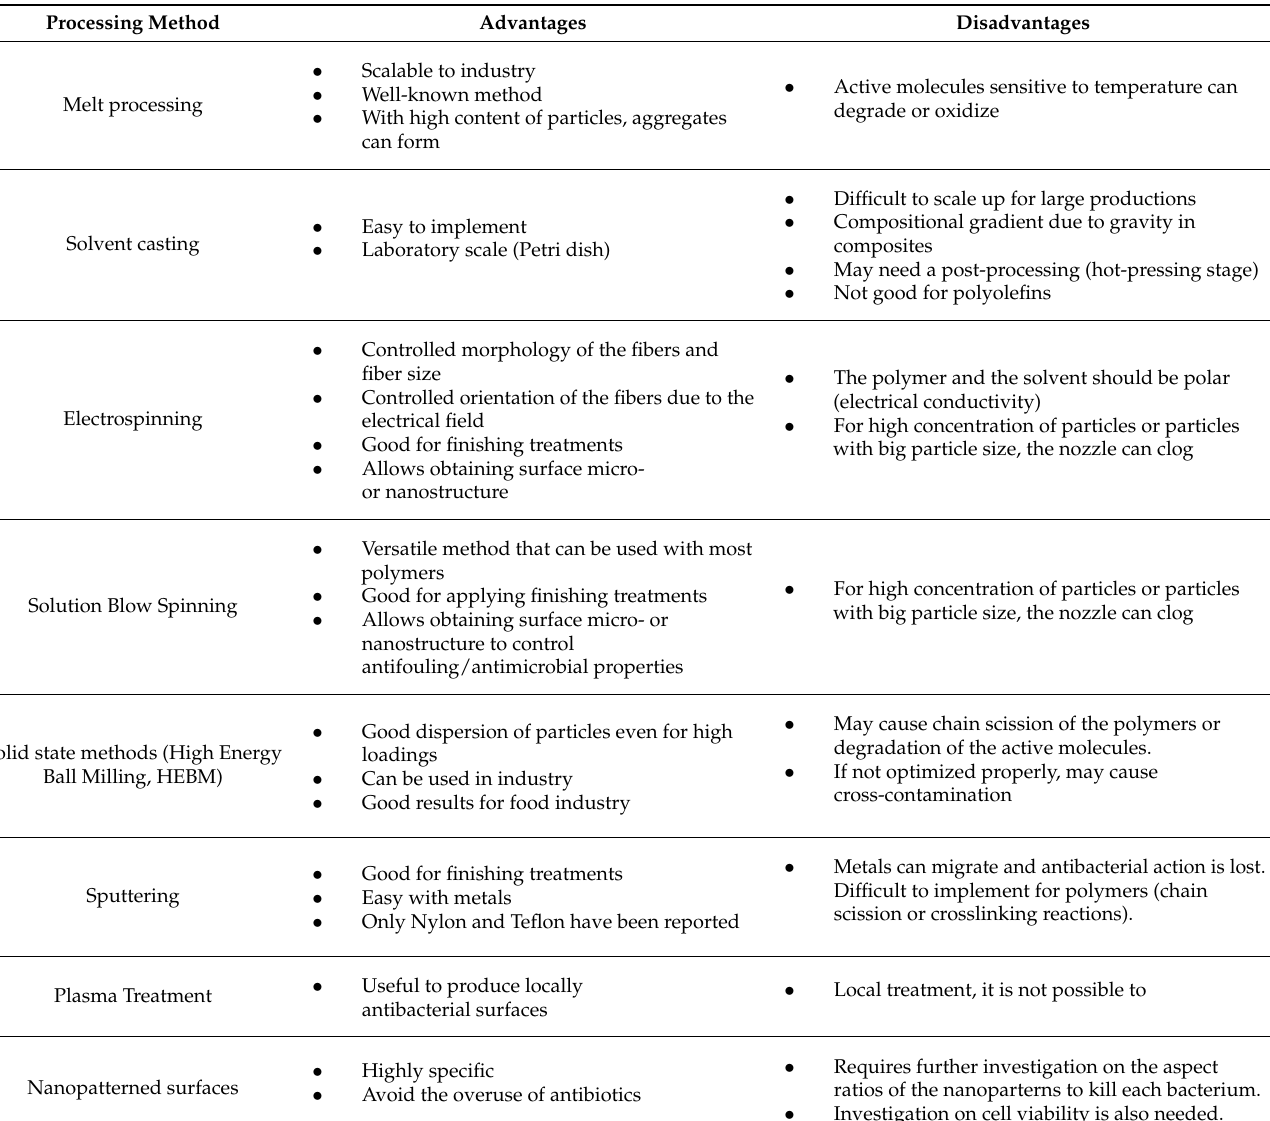
Table 1. Summary of the main processing methods, advantages and